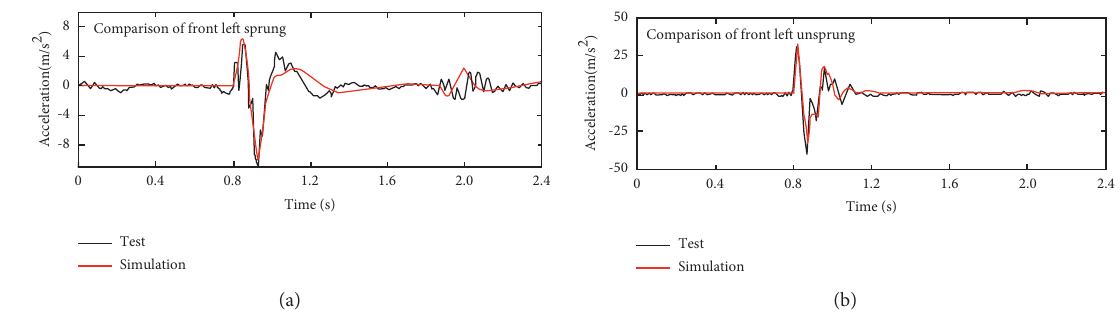
Figure 9: Vertical acceleration between front left sprung mass and front left unsprung mass.